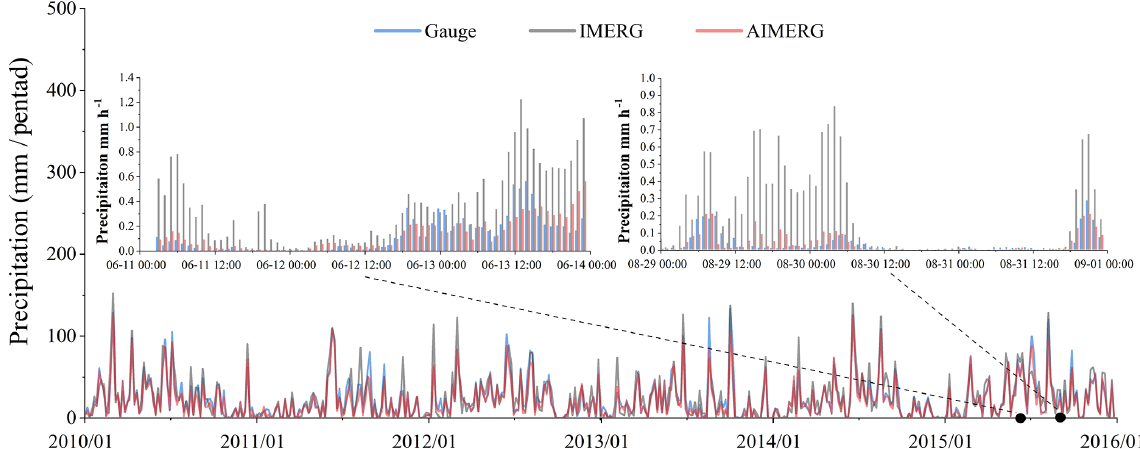
Figure 10. The temporal patterns of mean areal precipitation of IMERG, AIMERG, and the ground observations from the independent hydrological stations at a daily/hourly scale in the Zhejiang province in 2010–2015.